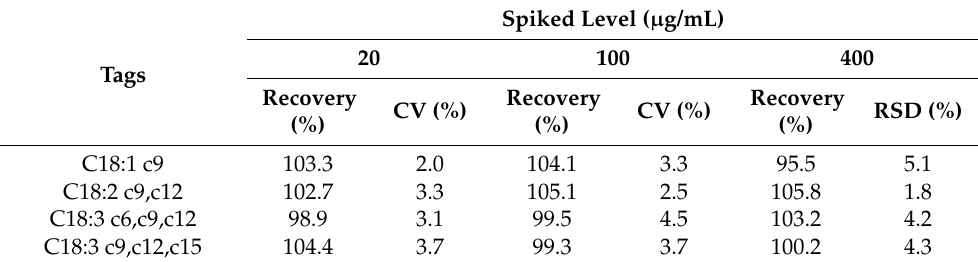
Table 3. Recovery experiments with 4 TAGs spiked in whey solution ( n =